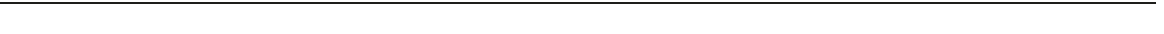
Fig. 3 Identi fi cation and characterization of PKD2 hydrophobic gate. a Each single underlined aa of human PKD2 was mutated to N. Representative I – V curves were obtained in oocytes expressing WT or a mutant PKD2, as indicated, in the presence of the divalent free Na-containing solution (in mM): 100 NaCl, 2 KCl, 10 HEPES at pH 7.5. The gain-of-function mutant F604P (in the S5 helix) serves as a positive control and water-injected oocytes as a negative control (Ctrl). b Averaged currents at + 80 mV obtained under the same experimental conditions as in a in expressing or control oocytes, as indicated. Currents were averaged from 10 – 13 oocytes from at least three batches. Data are presented as mean ± SEM. c Upper panel, averaged currents obtained as in panel a for PKD2 WT, A678 mutants, L677N or F604P ( n = 8 – 13). Data are presented as mean ± SEM. Lower panel, western blot of surface biotinylated and total protein of PKD2 WT or indicated mutants. d Upper panel, the PKD2 L677 was replaced with different aa as indicated. Shown are averaged currents obtained as in a , with F604P as a positive control ( n = 10 – 14). Data are presented as mean ± SEM. Lower panel, western blot showing total protein of PKD2 WT or indicated mutants present in the injected oocytes. e Representative I - V curves for F604P/L677 double mutants, as indicated, under the same condition as in a . f Averaged currents at + 80 mV recorded from oocytes injected with cRNA of the indicated PKD2 WT or F604P/L677 double mutants ( n = 8 – 12). Data are presented as mean ± SEM. g Averaged currents at + 80 mV obtained from oocytes expressing PKD2 WT, or indicated single or double mutants ( n = 9 – 12). Data are presented as mean ± SEM. h Averaged currents at + 80 mV obtained from oocytes expressing PKD2 WT, L677N or L677N/N681L mutant. Data are presented as mean ±